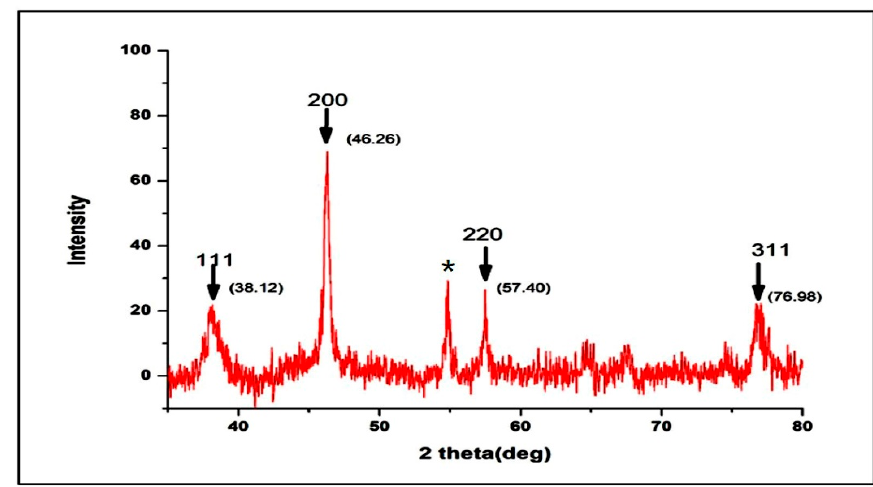
Figure 4. XRD pattern of the UD-AgNPs with peak values.